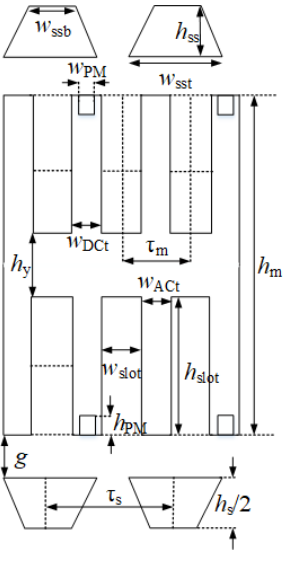
Figure 4. Design variables. Table 1. Structure design